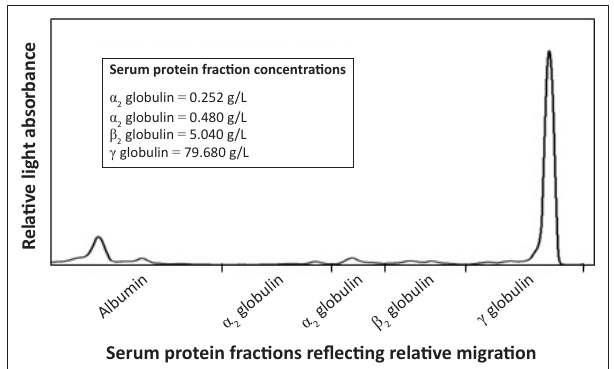
Serum protein fractions reflecting relative FIGURE 1: Serum protein electrophoresis demonstrating a monoclonal gammopathy with a paraprotein peak in the gamma band.